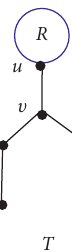
Figure 15: The tree T .